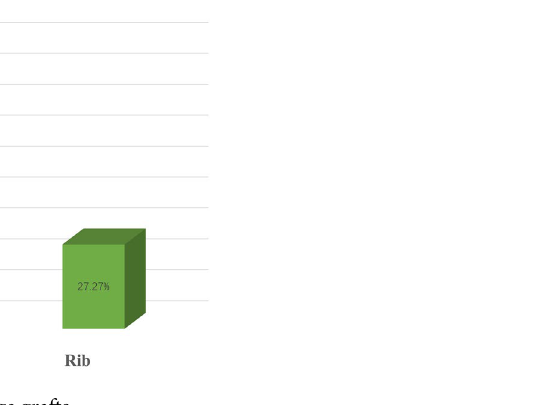
Figure 6. Patients’ donor sites of cartilage